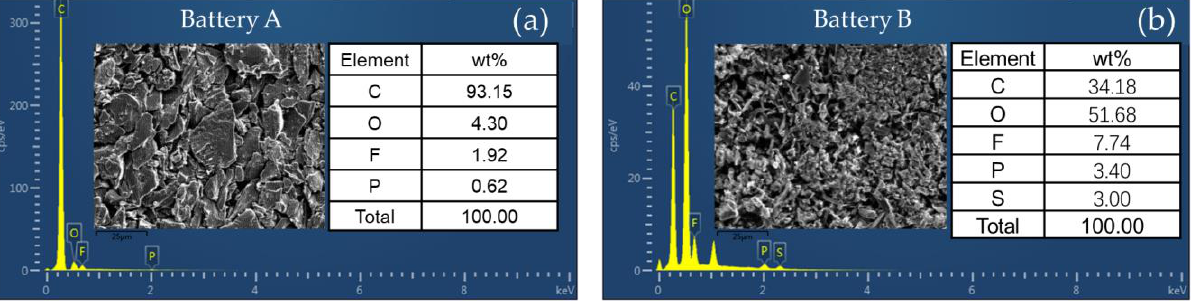
Figure 9. The EDS results of the negative electrode: ( a ) Battery A; ( b ) Battery B.